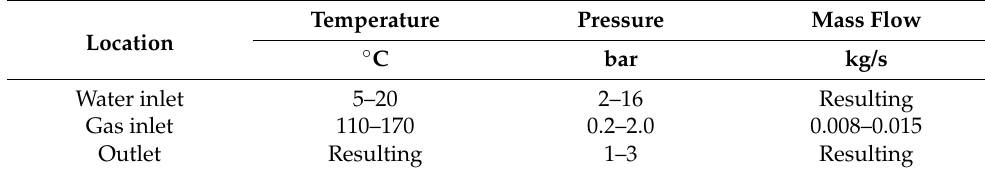
Table 1. The range of operating variables.